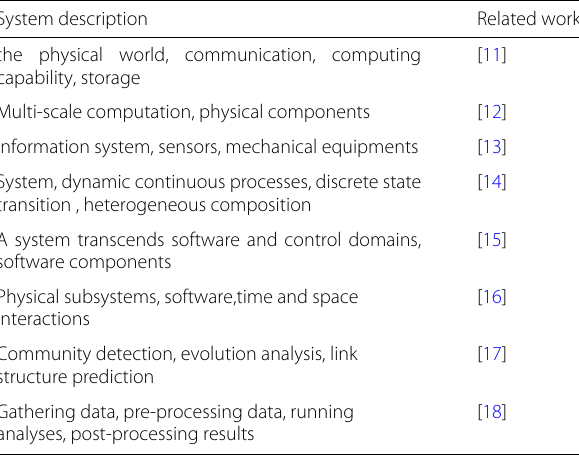
Table 1 Summary of Literatures about the Definition of CPS System